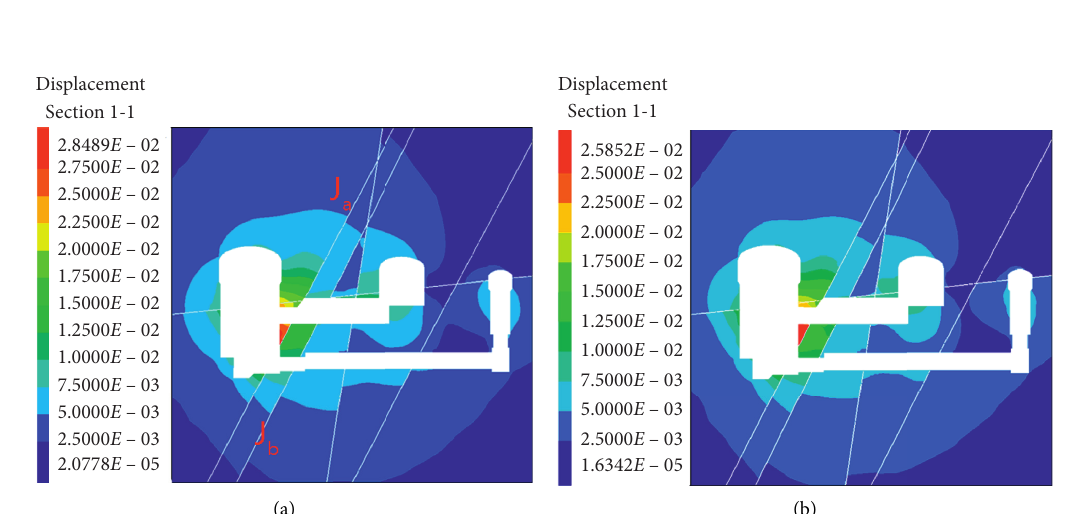
Figure 10: Total displacement contour (m) along 1 # set (section 1-1) of the unsupported (a) and supported condition (b).